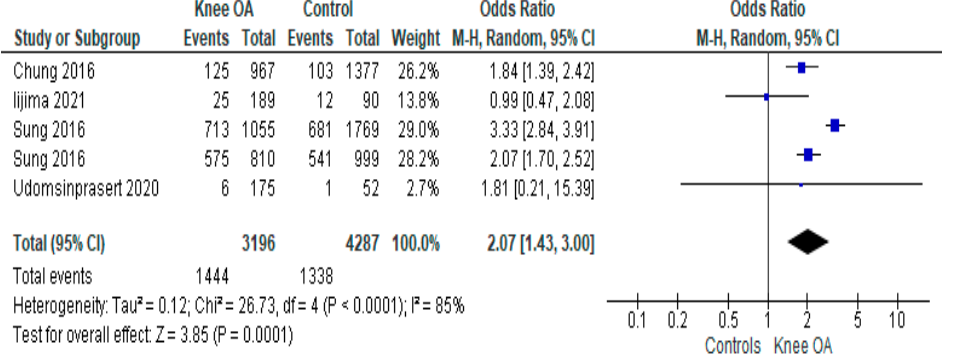
Figure 2. Prevalence of sarcopenia in patients with knee osteoarthritis versus controls in cross-sectional studies